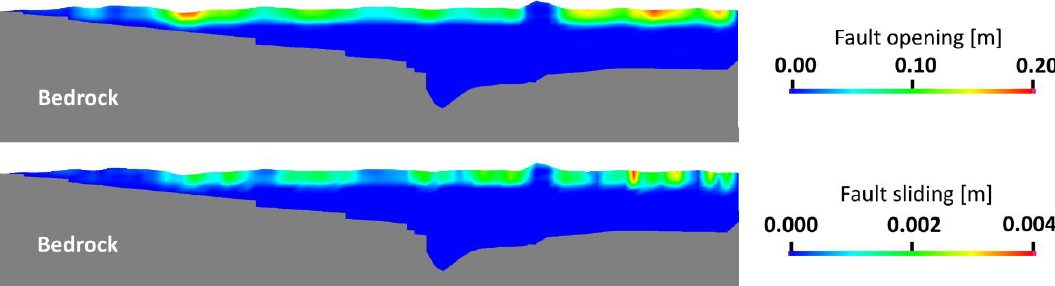
Figure 3. Test case 1: opening and sliding of the ground rupture after 10 years of water withdrawal.